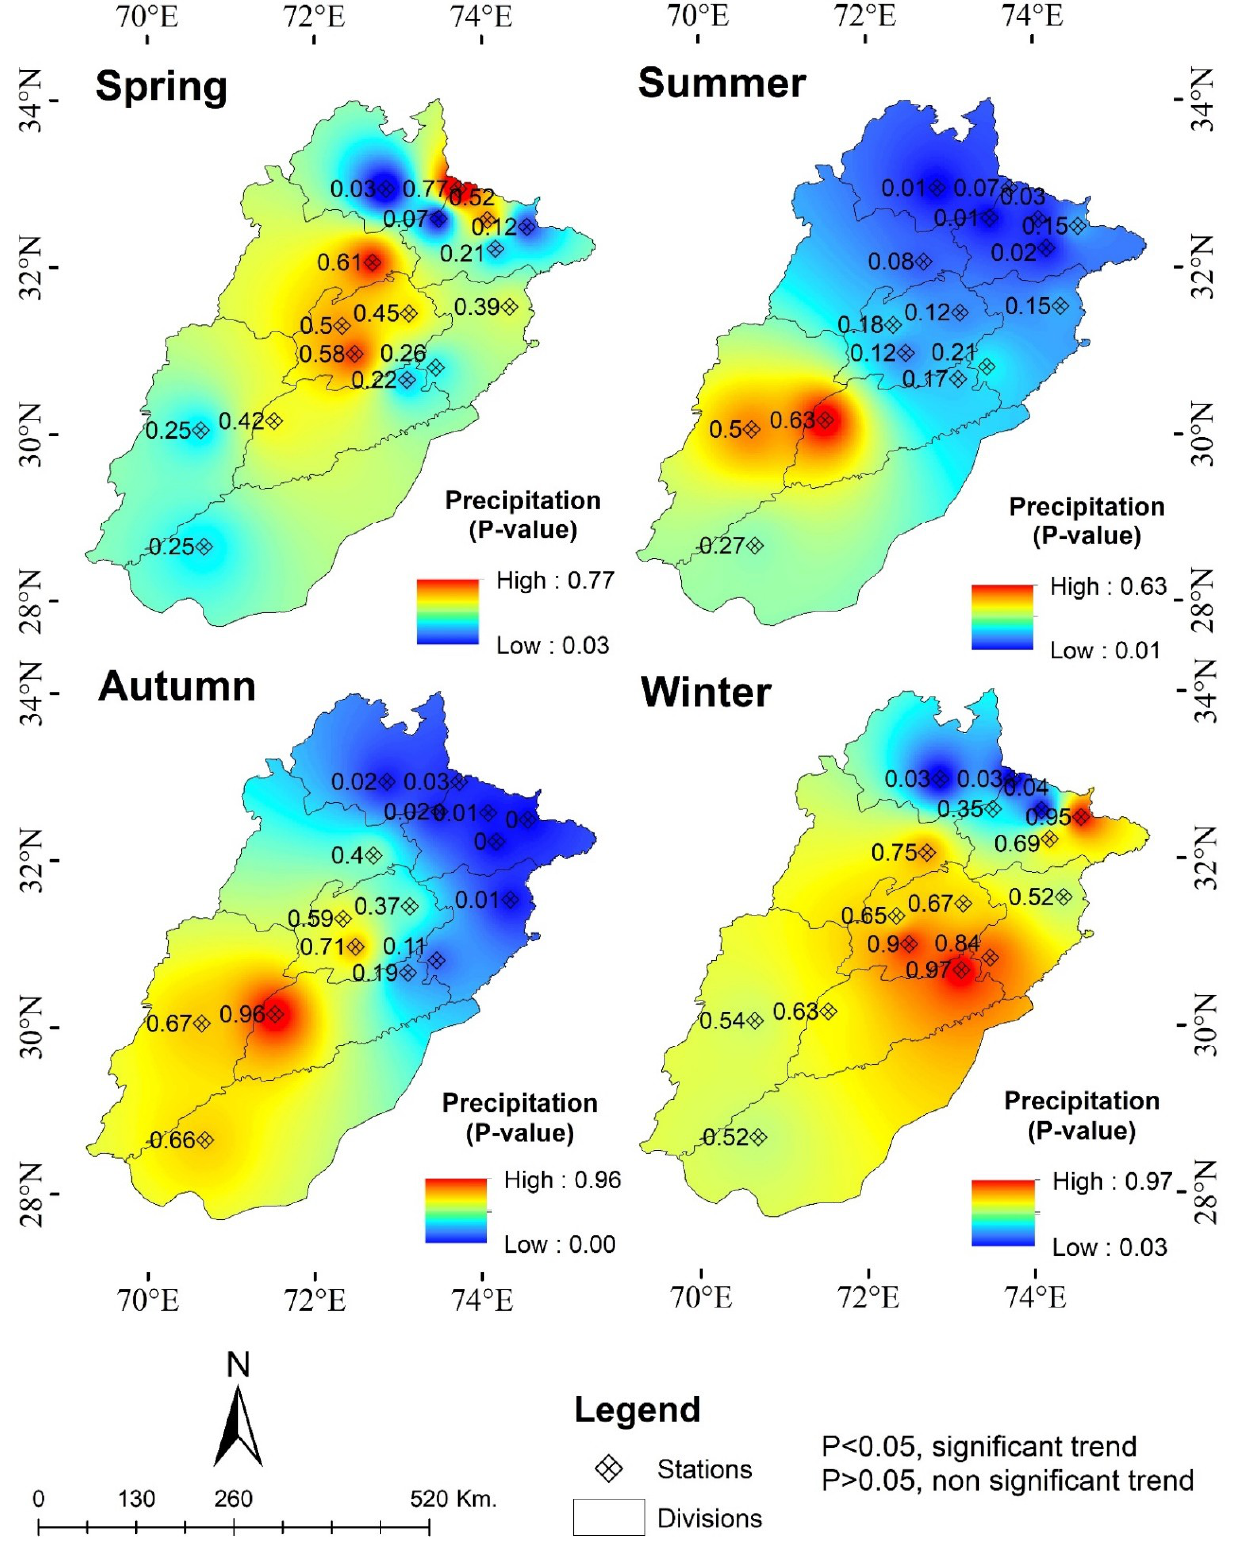
Figure 6. Seasonal p -values and the trends in precipitation (mm) of the 16 stations of Punjab, Pakistan, over the period 1979–2014.